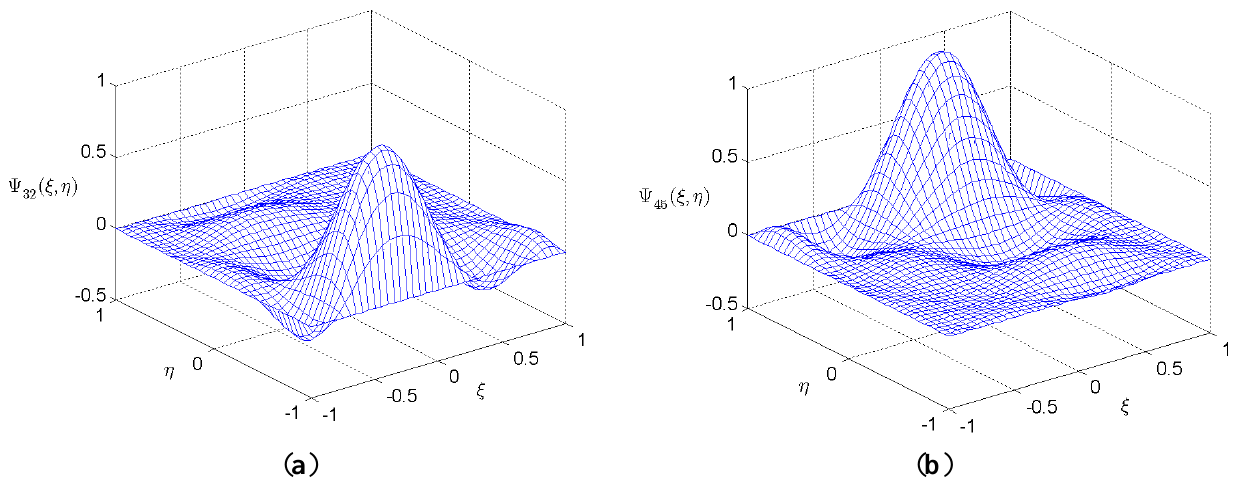
Figure 3. Selected shape functions for a 36-node spectral element. ( a